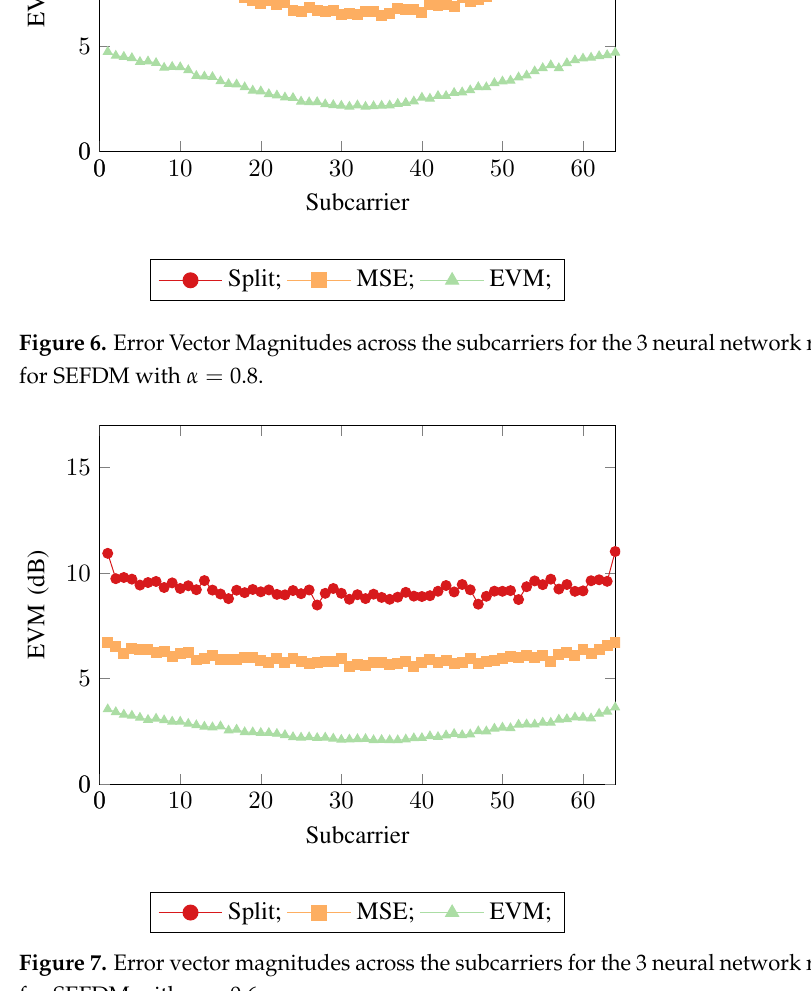
Figure 7. Error vector magnitudes across the subcarriers for the 3 neural network receiver approaches for SEFDM with α =